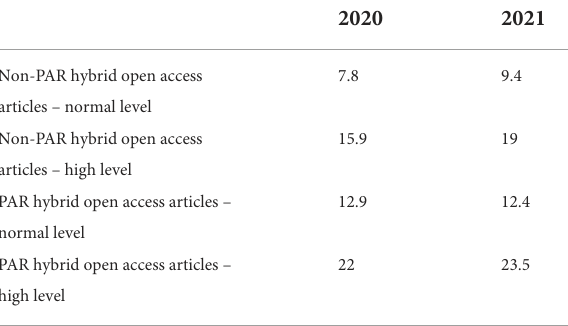
TABLE 4 Shares of hybrid open access articles on the normal level compared with hybrid open access articles on the high level in 2020 and